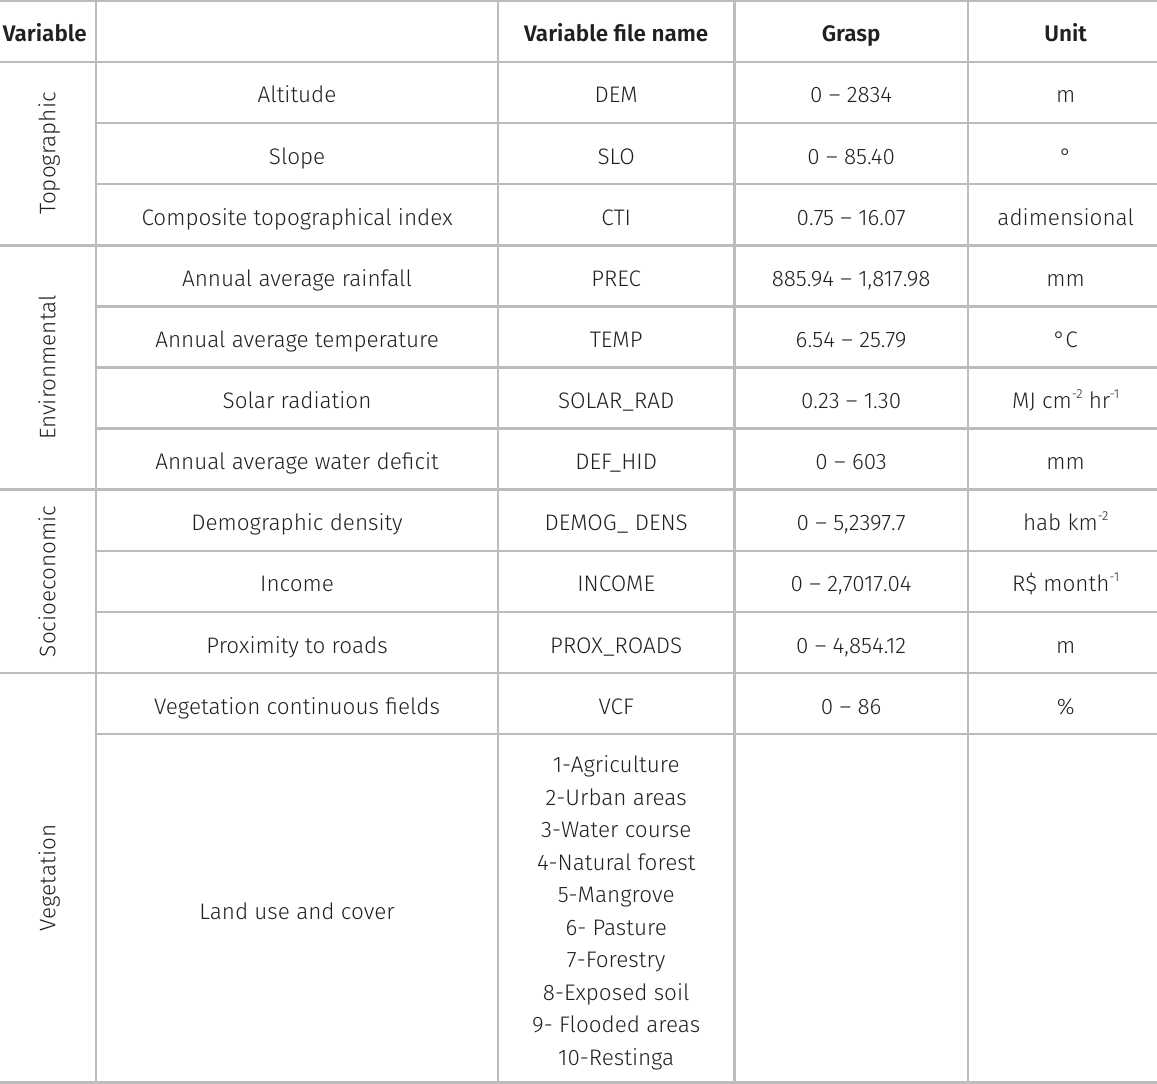
(Table I), including aspects topographical (Supplementary Material - Figure S1), climatic (Figure S2), socioeconomic (Figure S3) and vegetation (Figure S4). Variables from various databases were then processed into raster image, with spatial resolution of 250m, in accordance with procedures described in Supplementary Material. Geographical data were configured in accordance with geocentric reference system (SIRGAS 2000) and integrated into ArcGis/ArcInfo 10.4 GIS environment. Table I. Predictive variables considered in the decision tree analysis.